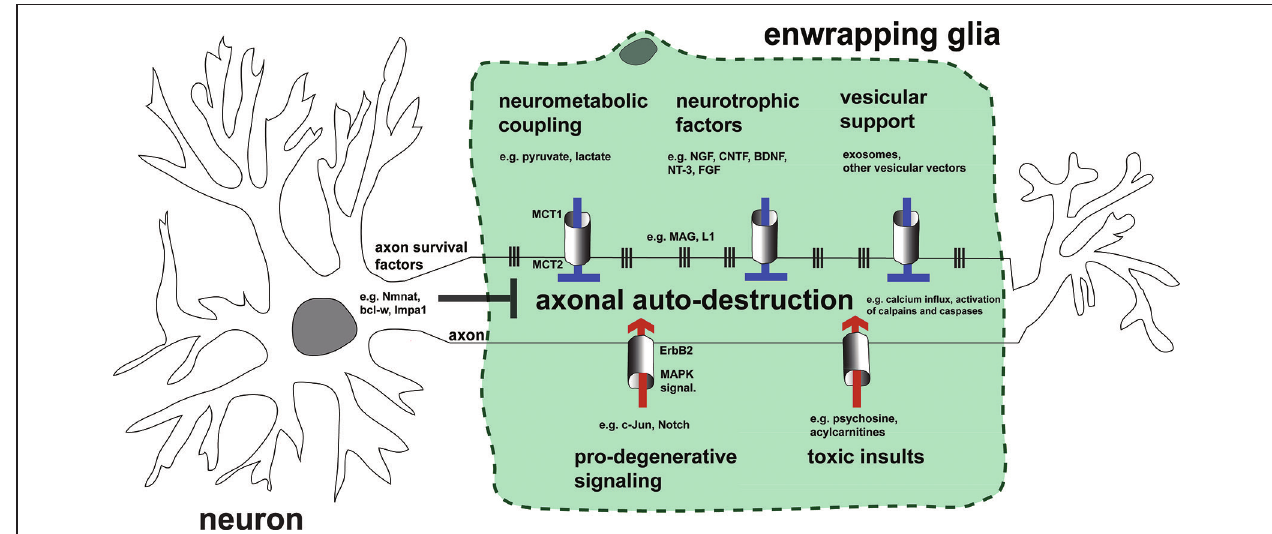
FIGURE 3 | Hypothetical model summarizing impact of EG on axonal integrity by the mechanistic themes discussed . Preservation of healthy axons is controlled by the cooperative action of both the neuron and adjacent glia by blocking endogenous axonal auto-destruction. Examples of neuronal mechanisms blocking this program(s) include somatic delivery of the putative axonal survival molecule Nmnat2 into axons, or the local translation of axonal maintenance factors such as Bcl-w. On the other hand, glia inhibit axonal death by transfer of metabolic substrates, neurotrophic factors, and vesicular